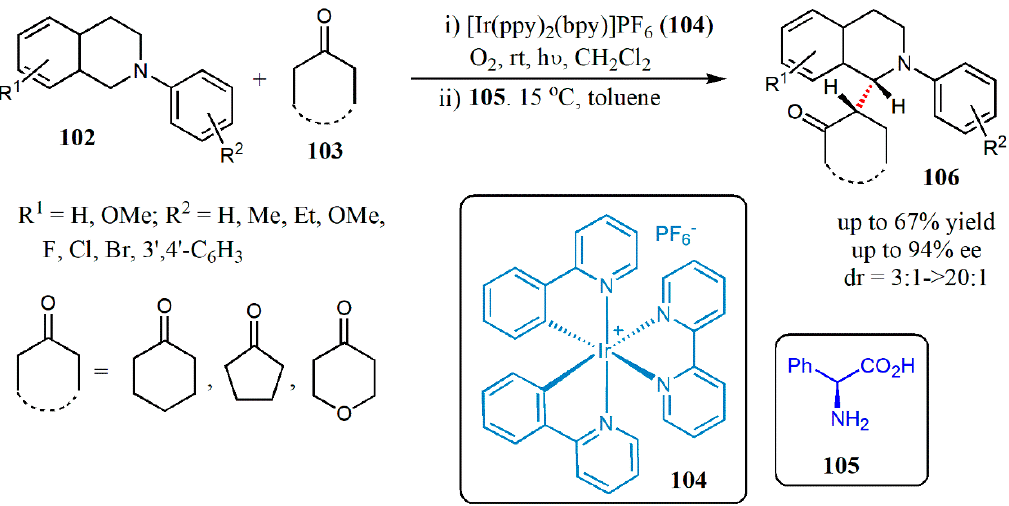
Figure 32. Cooperative asymmetric organocatalysis and photoredox catalysis for the α -functionalization of tetrahydroisoquinolines.